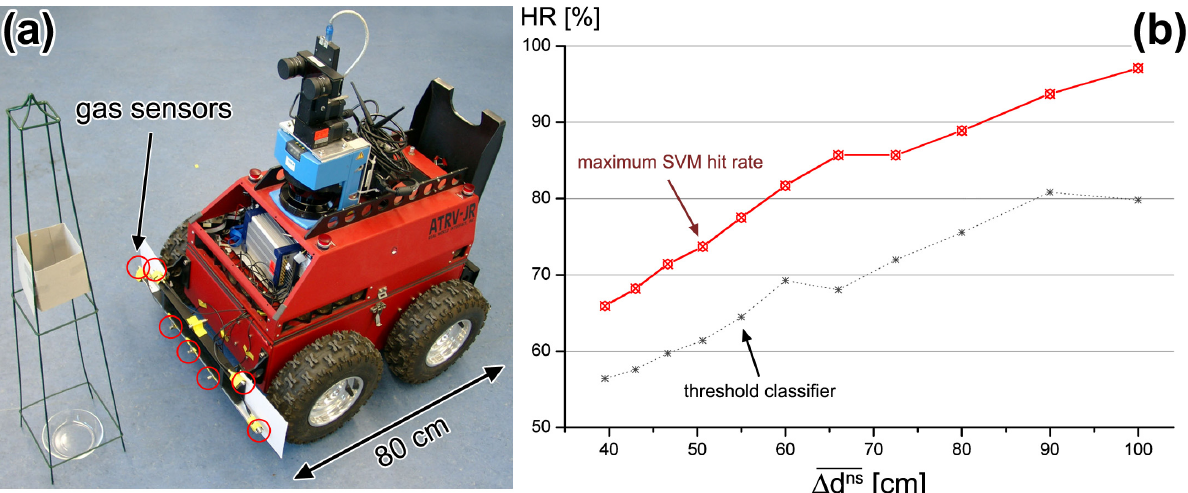
Figure 22 . (a) The gas-sensitive mobile robot Arthur in front of the source used in the gas